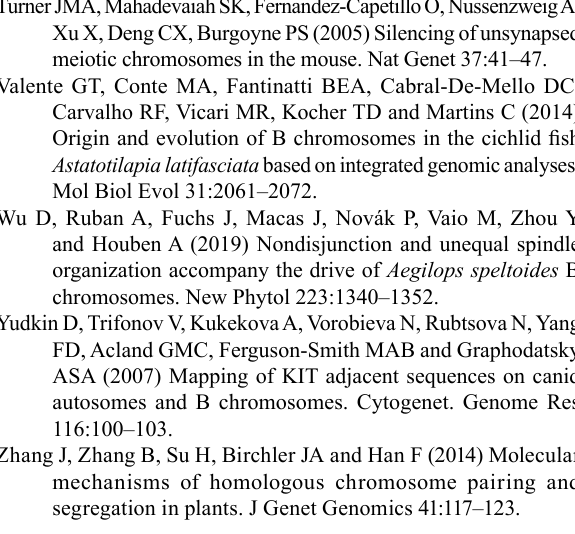
Figure S1 – Detection of P. paranae synaptonemal complexes through immunodetection using anti-medaka SYCP3 antibody. Table S1 – Relative transcription levels for the gene msh4 in B-carrying and B-lacking